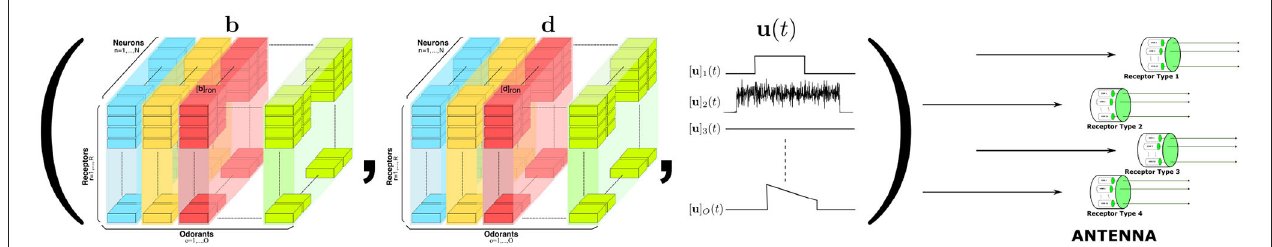
FIGURE 6 | Elements of the odorant space are defined by the odorant-receptor binding rate, dissociation rate and concentration amplitude tensor trio [ b , d , u ( t )]. For a given neuron n = 1,2,..., N , the binding rate and dissociation rate values are, respectively, denoted by [ b ] ron and [ d ] ron , for all r = 1,2,..., R , and o = 1,2,..., O . Single and/or odorant mixtures interact with the receptors expressed by the Olfactory Sensory Neurons in the Antenna